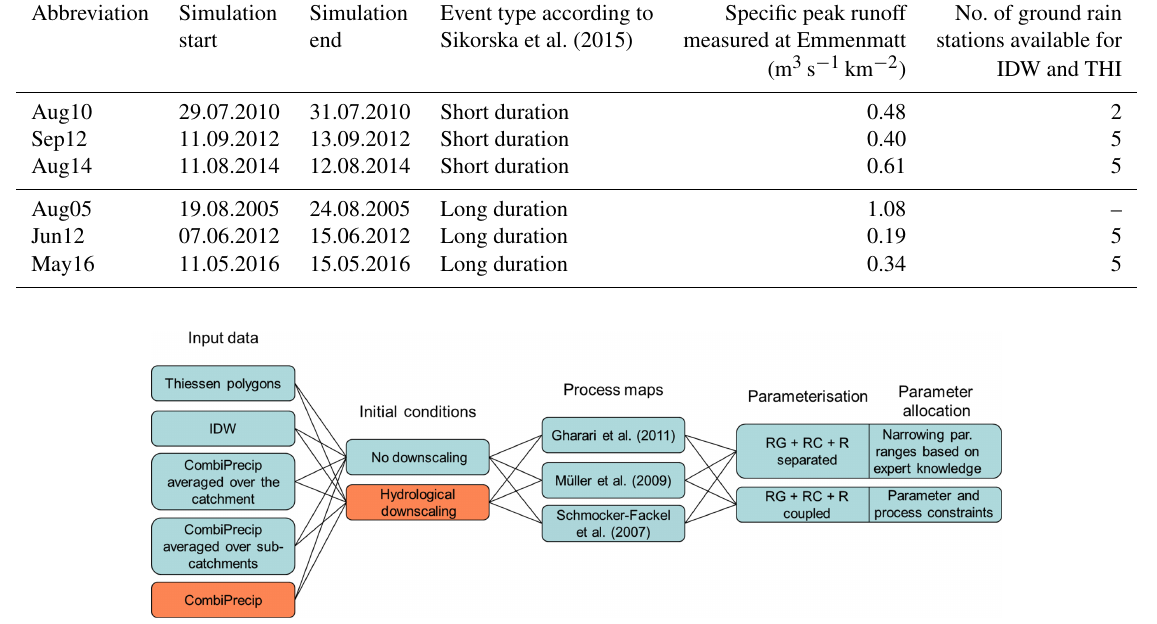
Figure 6. Diagram of the modelling chain combination performed for this study. The components with an orange background form the benchmark modelling chain. IDW = inverse distance weighting; RG = runoff generation; RC = runoff concentration; R =